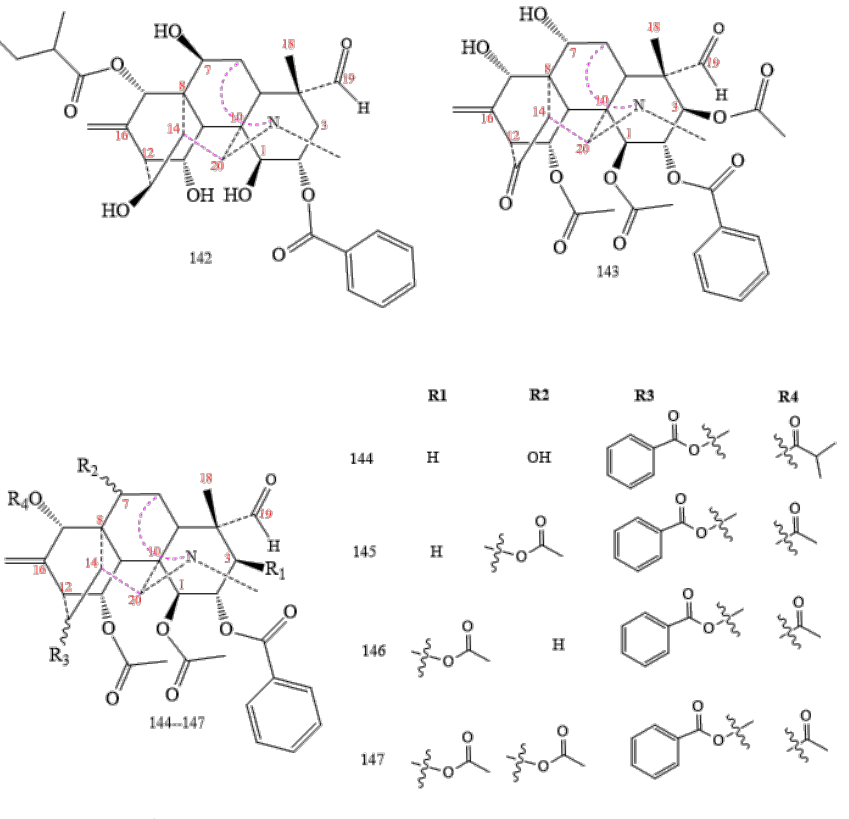
Figure 17. C 20 -vakognavine Das.